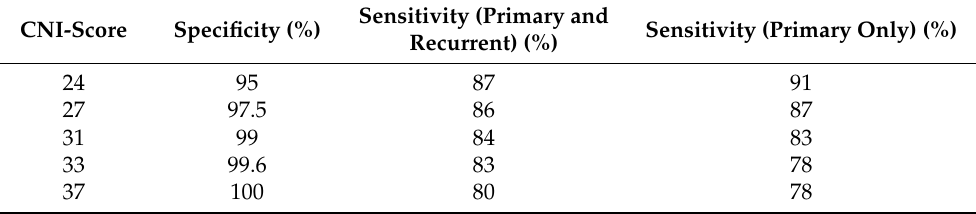
Table 2. Sensitivity and specificity for detecting ovarian tumors at various CNI-Score